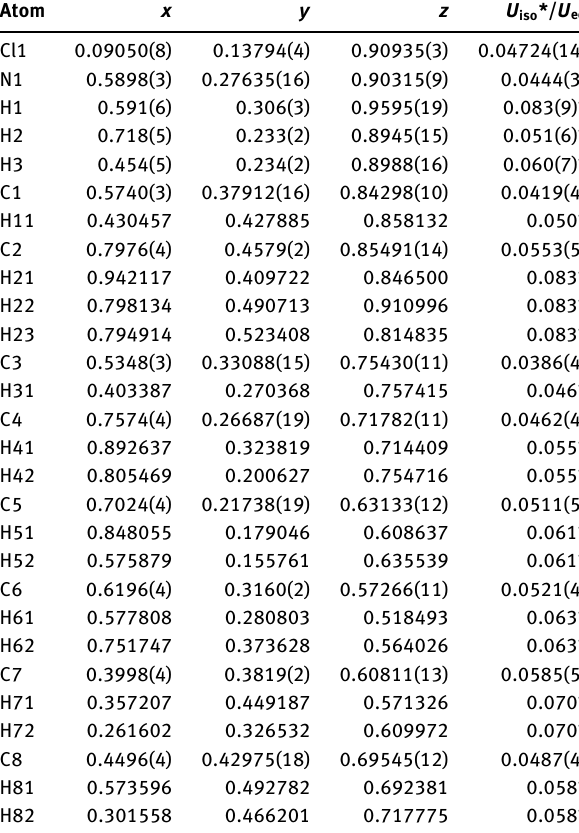
Table 2: Fractional atomic coordinates and isotropic or equivalent isotropic displacement parameters (Å 2